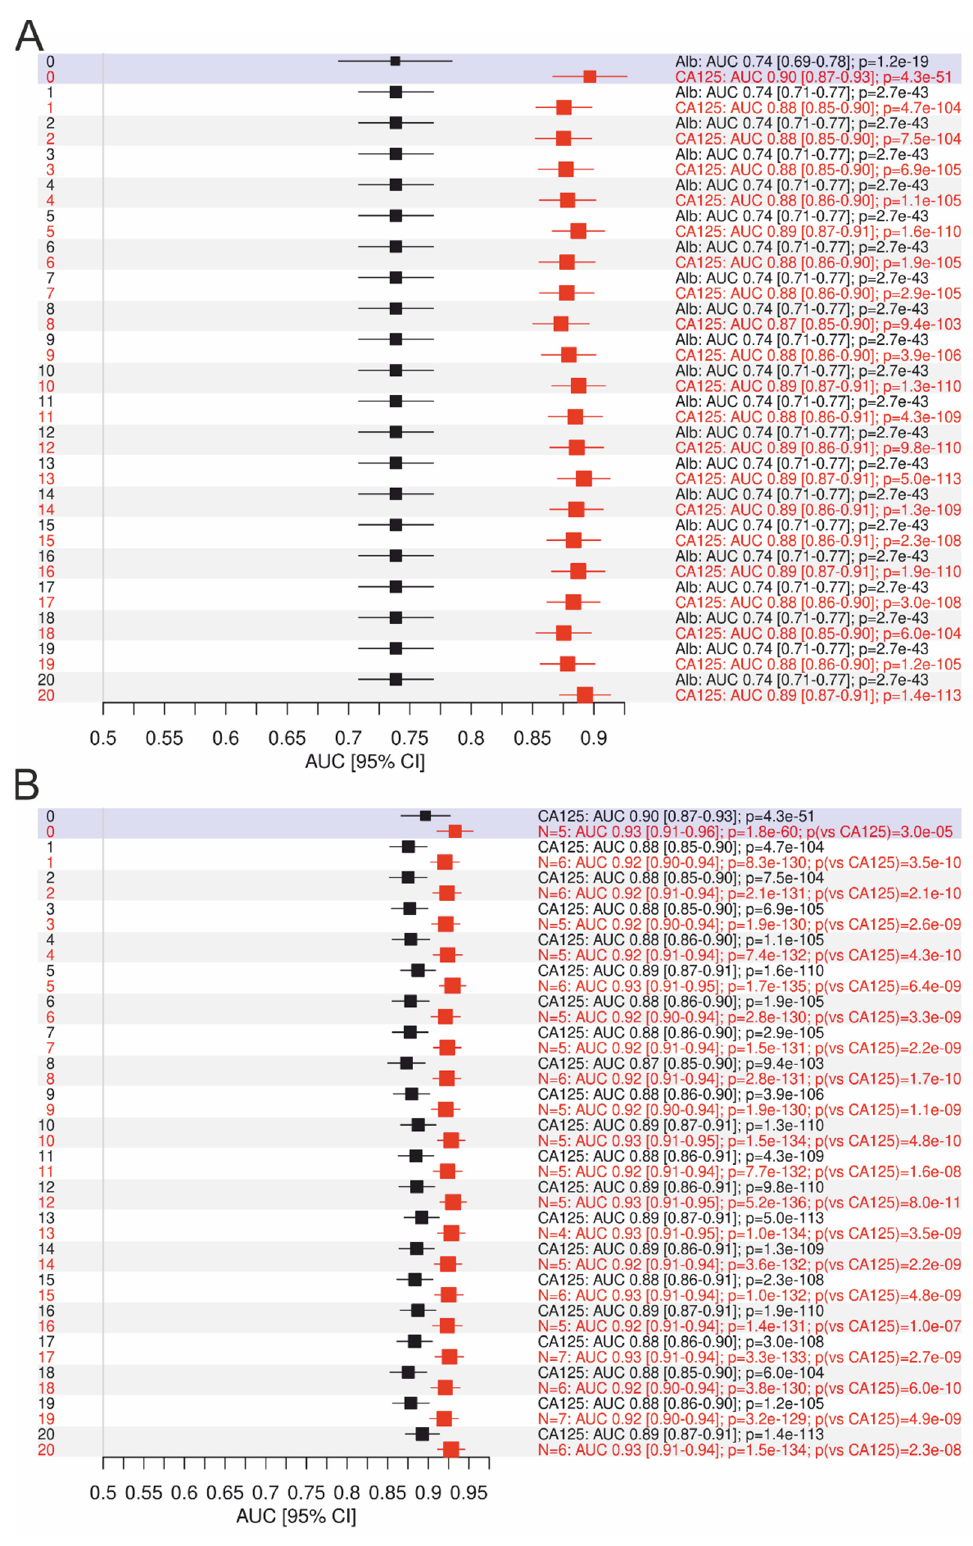
Figure 4. ( A ) The estimated AUCs (95% CI) of albumin (black) vs. CA125 (red) and ( B ) CA125 (black) vs. the models (red), performed with all 20 imputed datasets and the complete dataset (blue background). The first p -values compared the AUC estimates to 0.5 (as by chance). The last p -value (red) in ( B ) compared the CA125 AUC with the models AUC. Y -axis, number of imputed datasets; 0, the complete dataset.